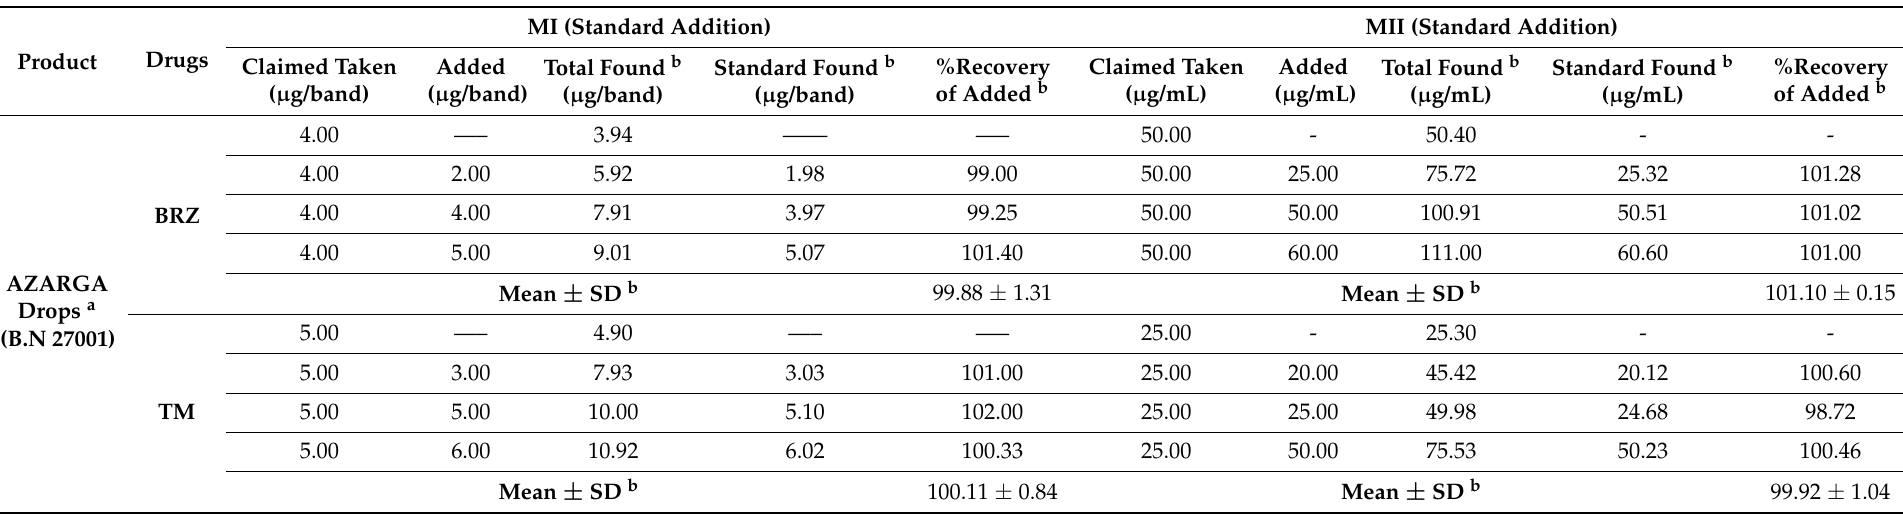
Table 2. Standard Addition Technique for the analysis of BRZ and TM in AZARGA ® eye drops by MI and